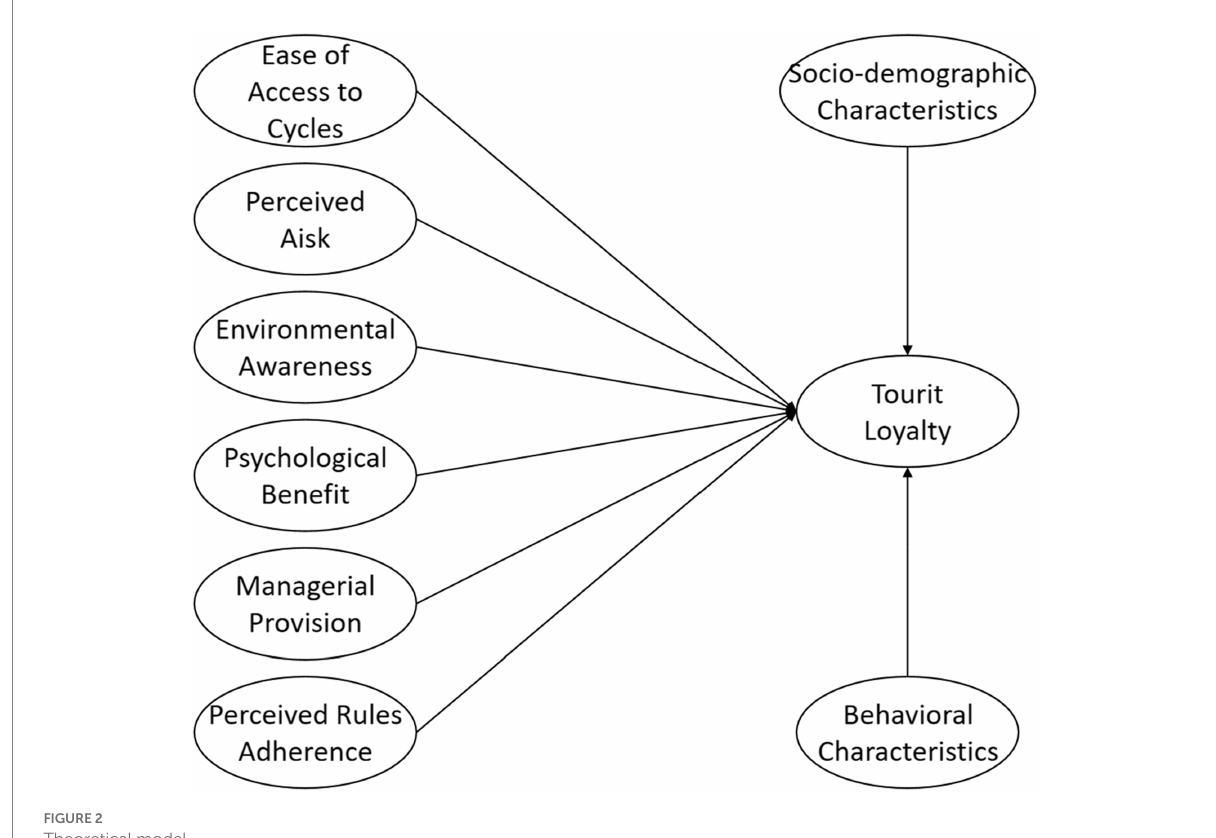
FIGURE 2 Theoretical